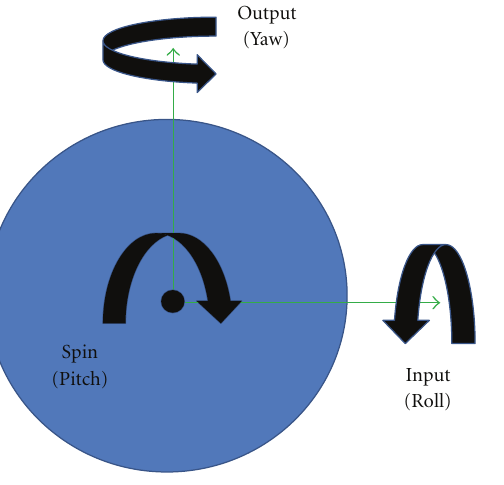
Figure 1: Gyro motion of one-wheel robot.